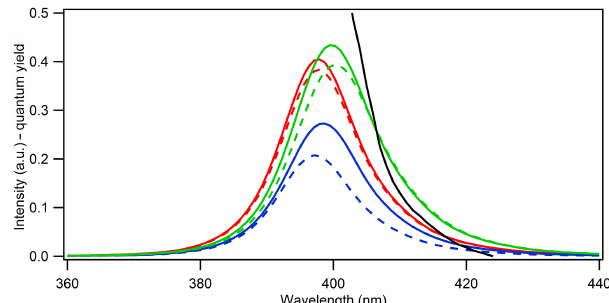
Figure 5. Spectral output vs. wavelength of two new, previously un- used BLC lamps (no. 1, solid green; no. 2, dashed green), two used lamps (no. 3, solid red; no. 4, dashed red) still within acceptable conversion efficiency, and two which fall below acceptable limits (no. 5, solid blue; no. 6, dashed blue). The NO 2 quantum yield is shown in black.